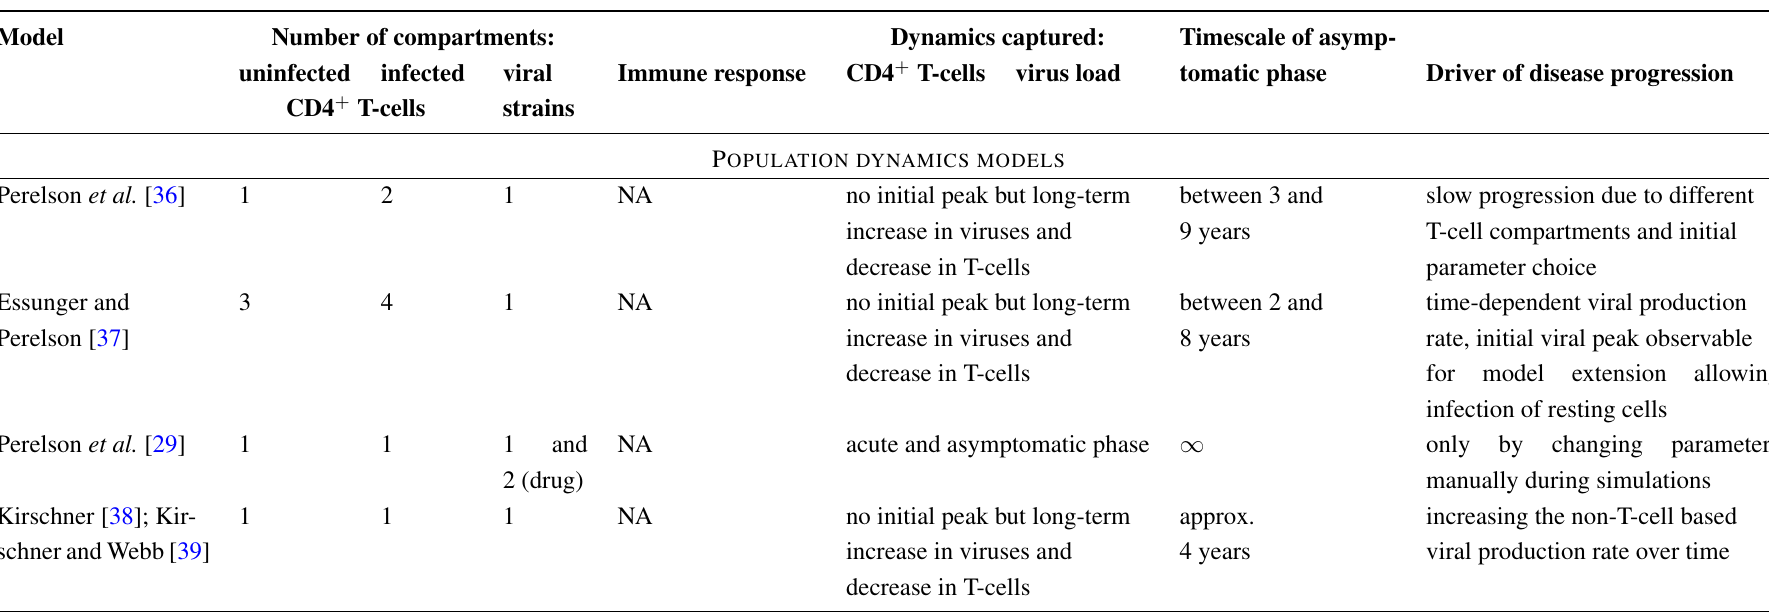
Table 2. Overview of HIV dynamics models. We list all the models described in the main text that focus on the course of an HIV infection. For each model, we indicate the number of CD4 + T-cell compartments, the number of virus strains (“ v ” means it varies